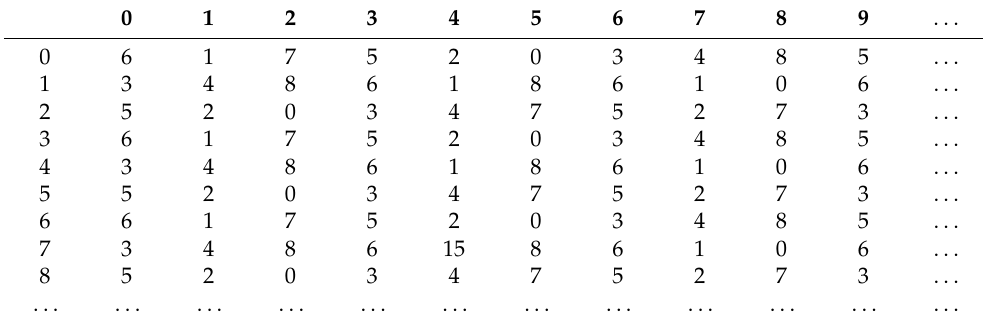
Table 3. Pixel extraction matrix.